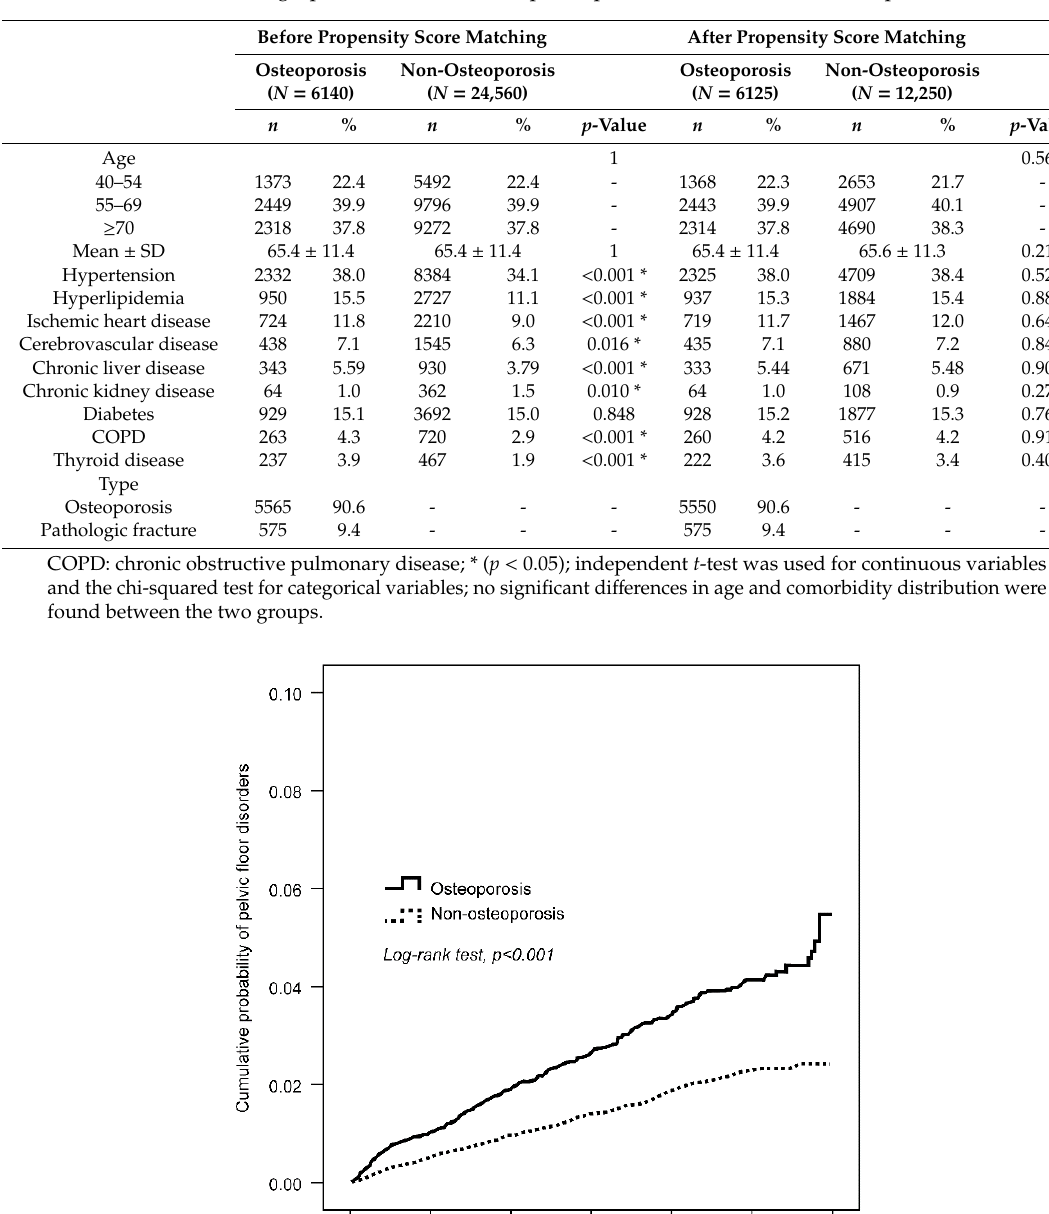
Table 1. Demographic characteristics of participants with and without osteoporosis.